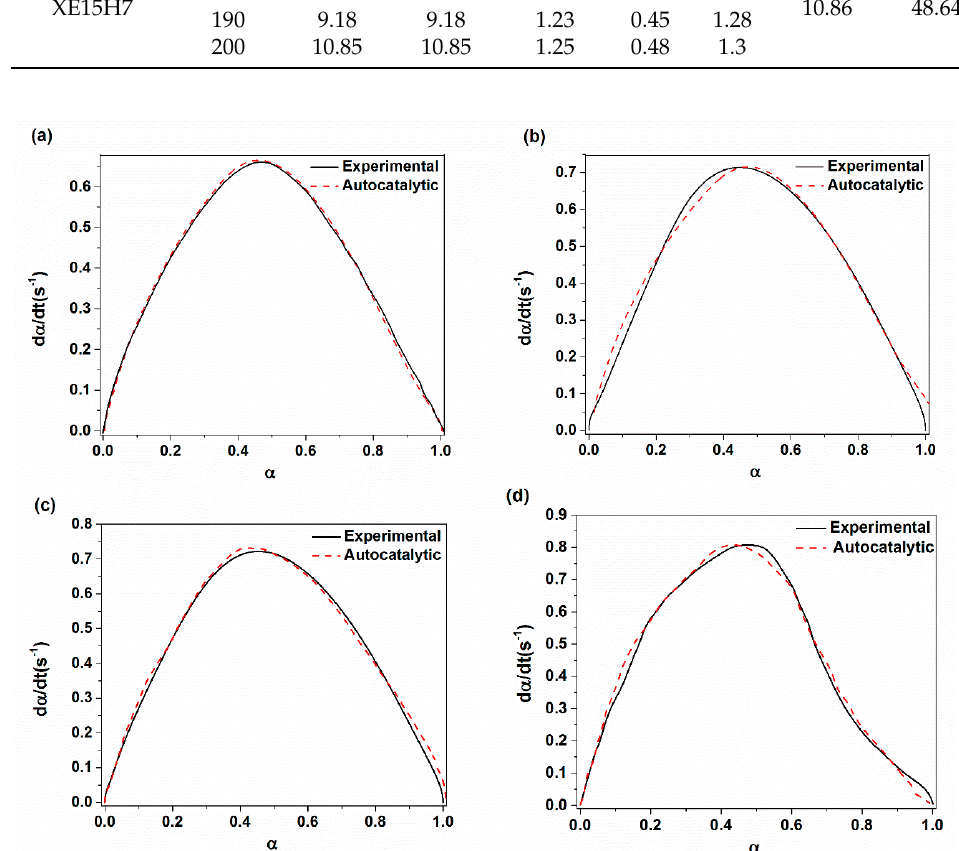
Figure 10. Comparison of experimental conversion rate with predicted ones through using autocatalytic approach and isothermal DSC curves with respect to cure conversion parameter for: ( a ) XE15; ( b ) XE15H3; ( c ) XE15H5; ( d ) XE15H7.